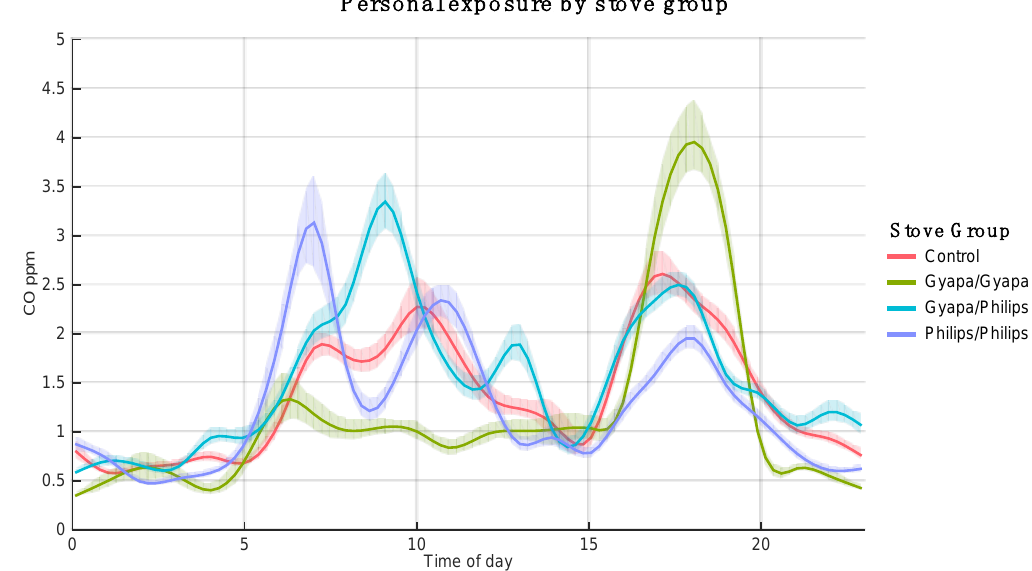
Figure 2. Spline-smoothed personal CO concentration by hour of day (0 = midnight) and stove group. The shaded bands represent 95% confidence intervals on the mean estimates.